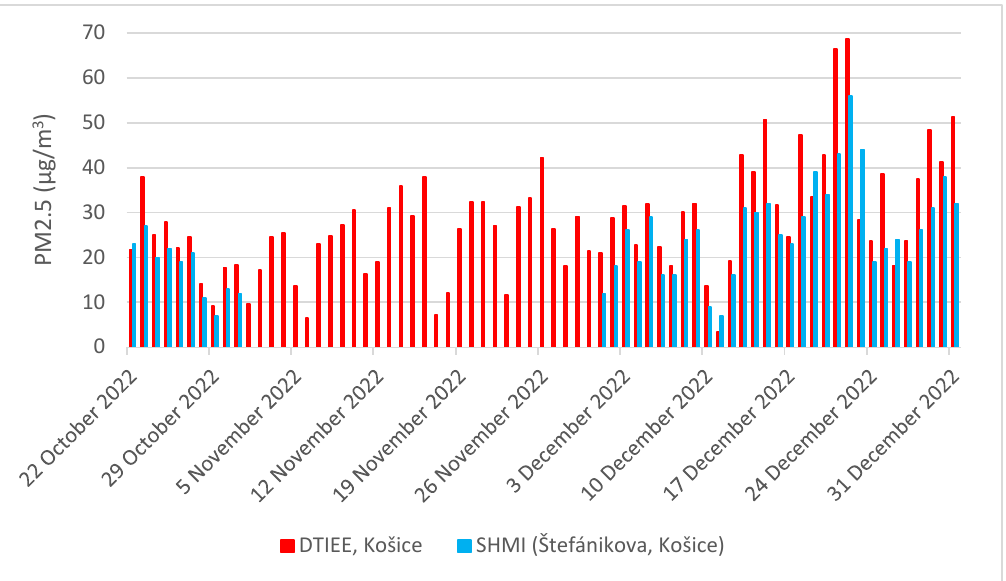
Figure 3. Daily averages of PM2.5 mass concentration at DTIEE (red bars) and Štefánikova, Košice (blue bars) measured from 22 October 2022 to 31 December 2022.